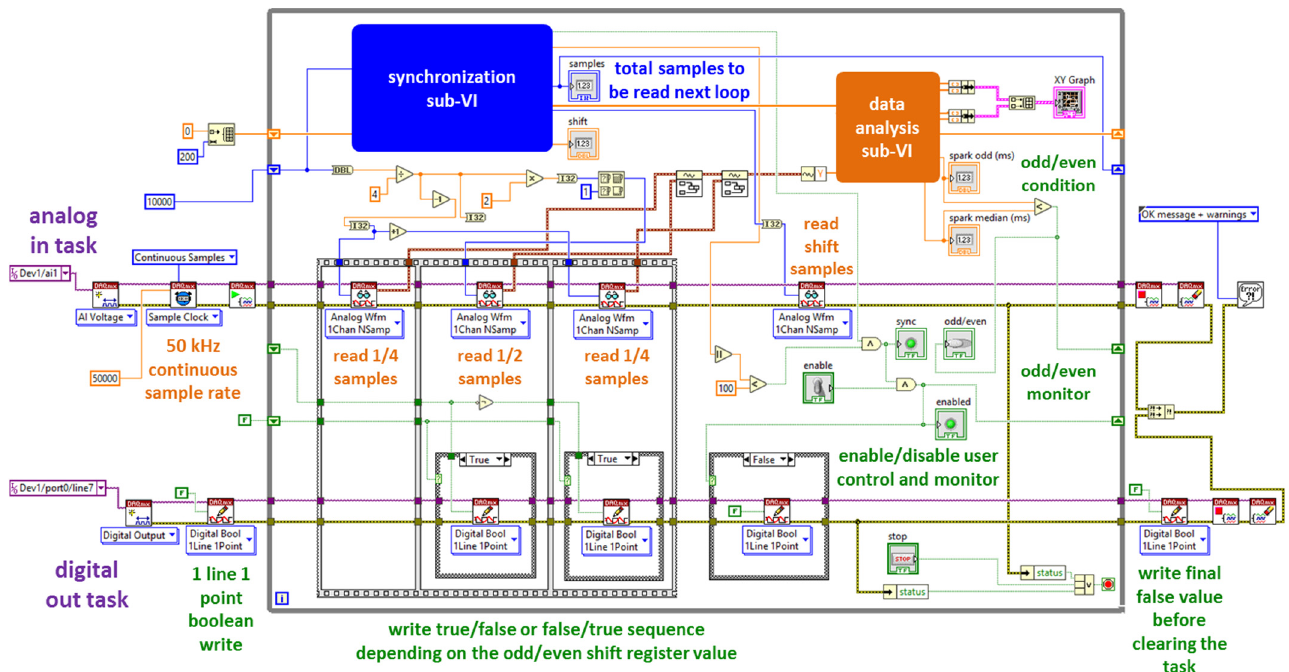
Figure 2. Schematic representation of the LabVIEW code.